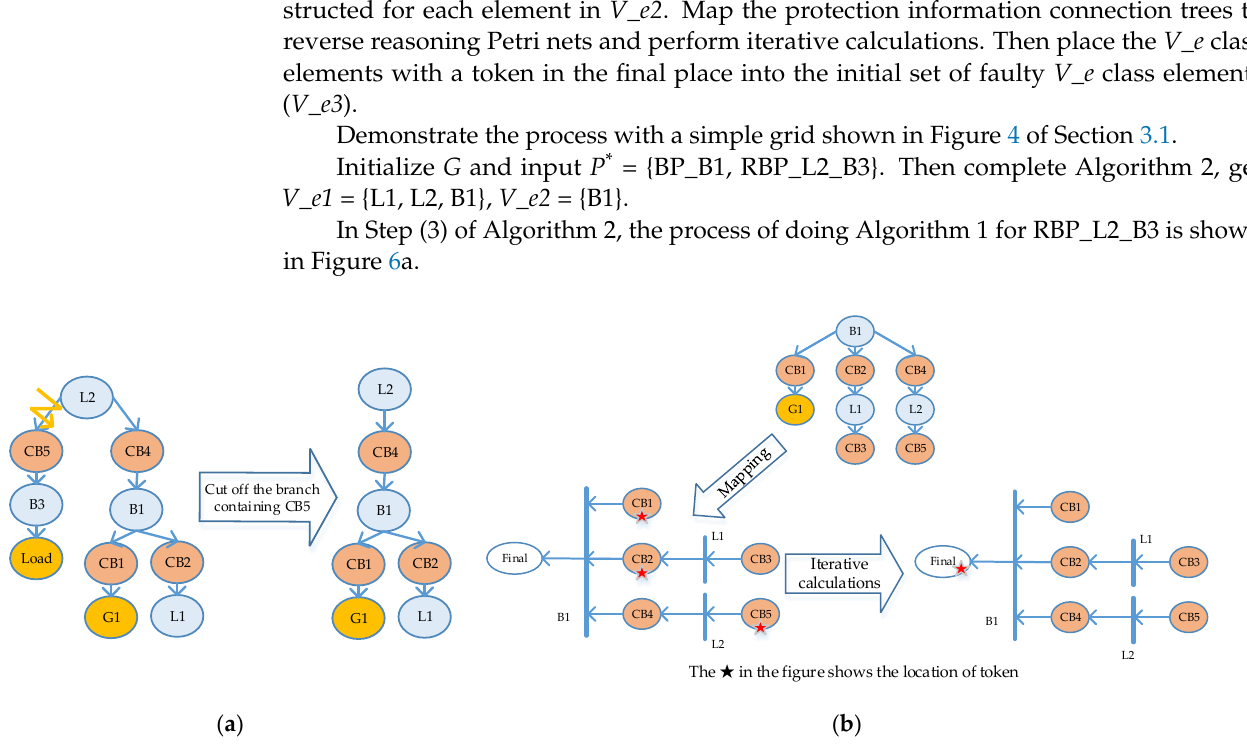
Figure 6. ( a ) Doing Algorithm 1 for RBP_L2_B3; ( b ) mapping and iterative calculations of B1. Map the protection information connection tree of B1 to a reverse reasoning Petri